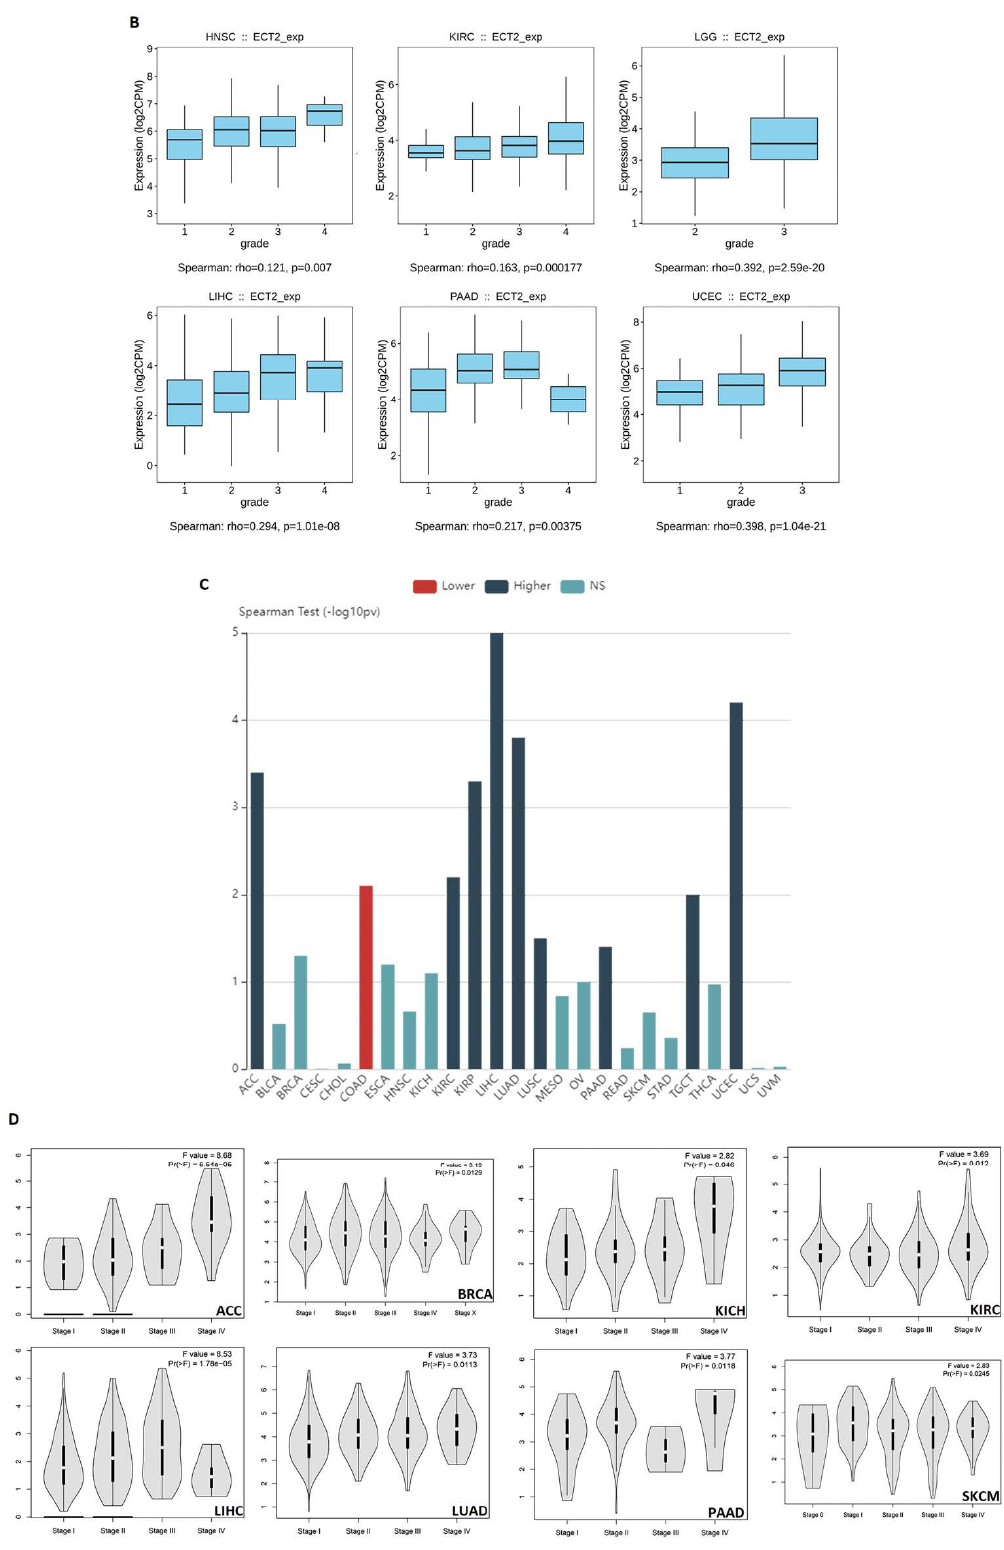
Figure 2. Correlation between ECT2 level and tumor stage and grade. ( A ) Bar chart showing the correlation between ECT2 level and tumor grade. ( B ) Box plot for tumors that experienced a positive correlation between ECT2 level and tumor grade. ( C ) Bar chart showing the correlation between ECT2 level and tumor stage. ( D ) Violin plot for tumors that experienced a positive correlation between ECT2 level and tumor